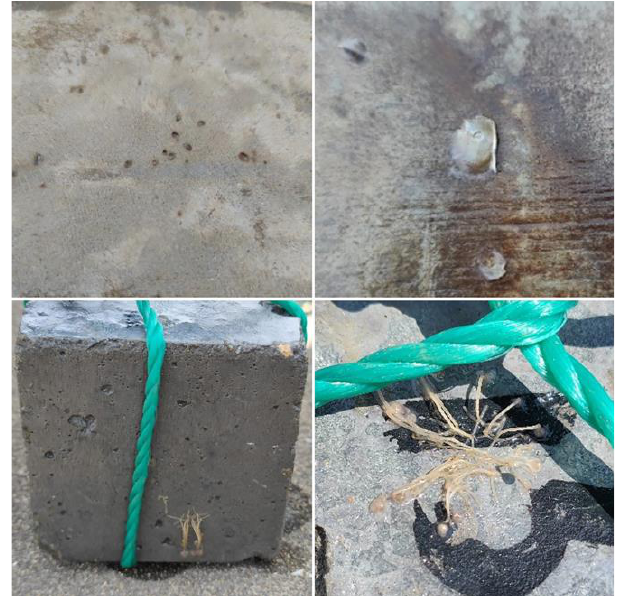
Figure 6. Attachment of biological organisms to concrete